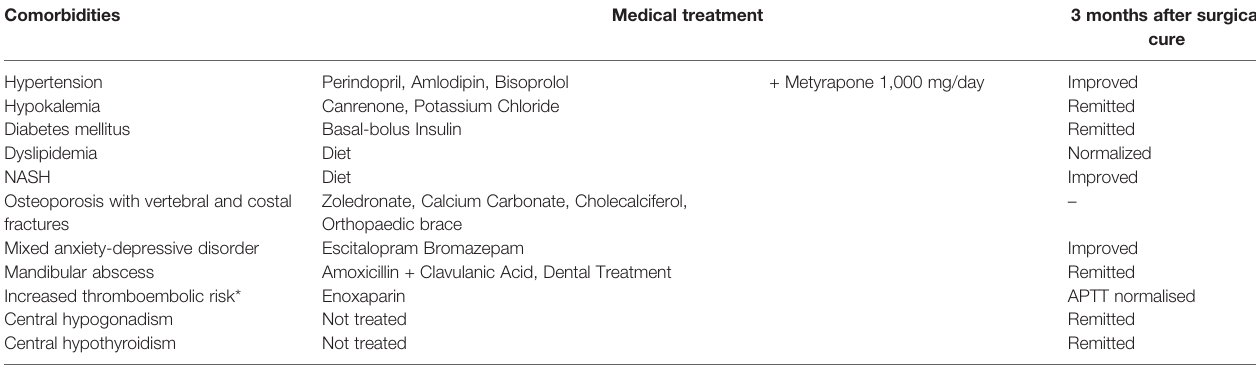
TABLE 2 | Associated comorbidities: treatment and progression.